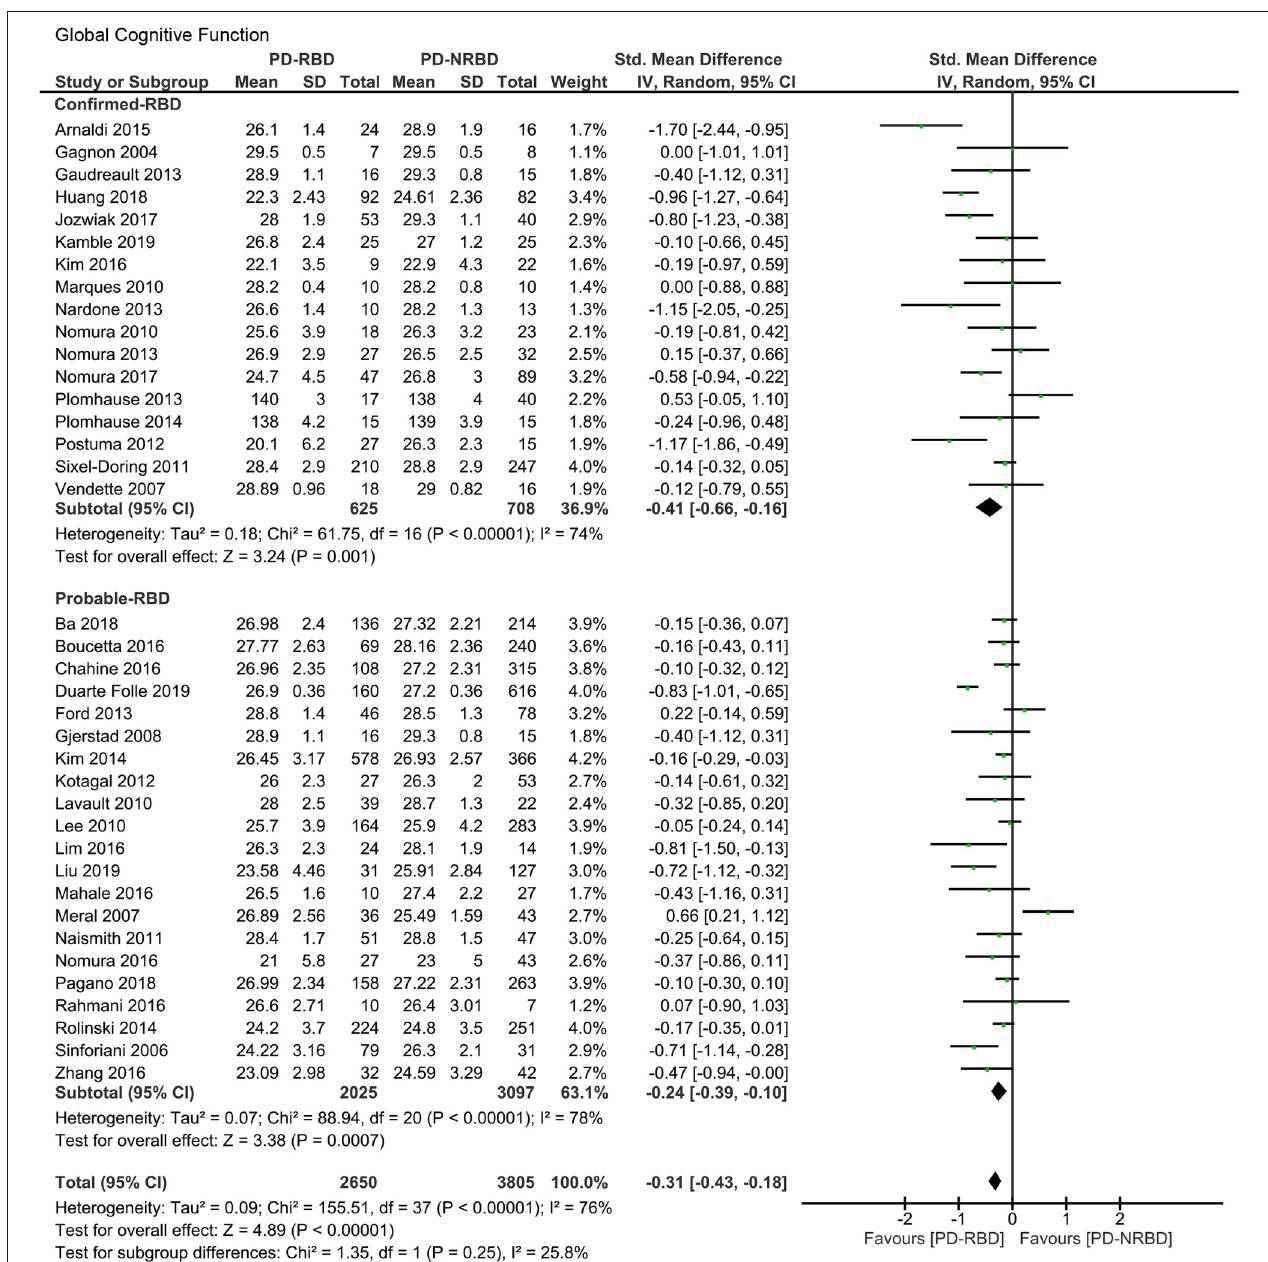
FIGURE 2 | Forest plot for global cognitive function with subtotals by the diagnosis of rapid eye movement sleep behavior disorder (RBD) displaying the effect size calculated using a random-effects model. SD , standard deviation; Std. Mean Difference , standardized mean difference; CI , confidence interval.